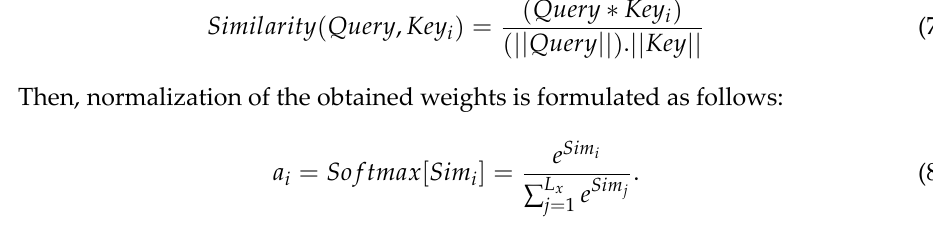
Figure 6. Attention mechanism.